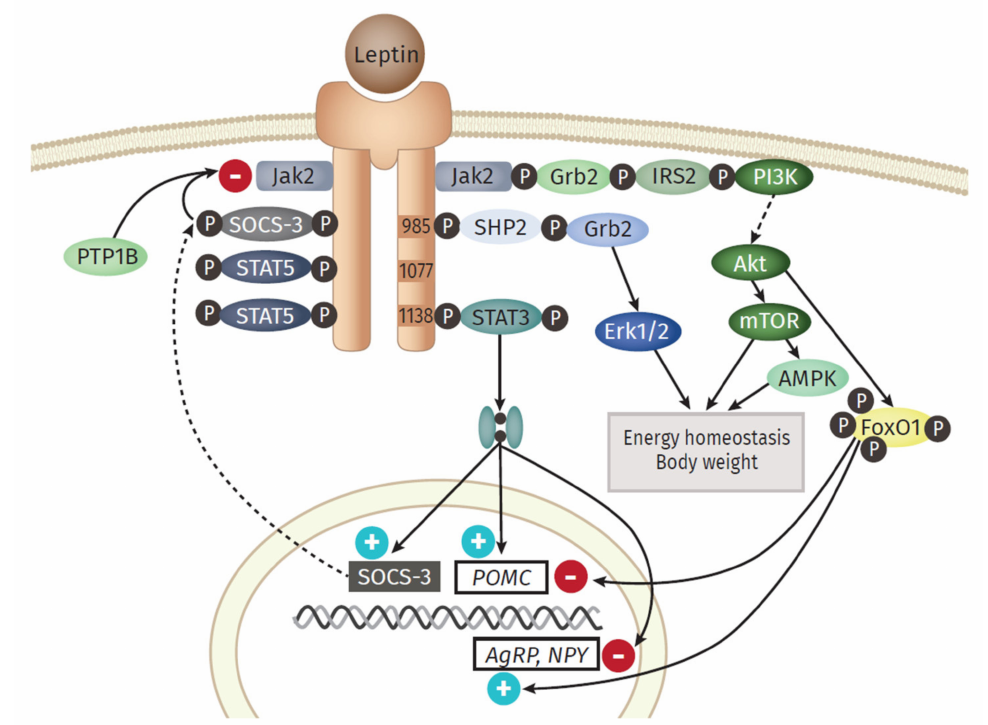
Figure 2. Overview of the leptin signaling pathway. The long isoform of the leptin receptor (ObRb) possesses the whole intracellular domain, with the conserved tyrosine residues (Y985, Y1077, Y118). The central function of leptin in the hypothalamus is regulated via the activation of anorexigenic neurons and orexigenic Neuropeptide Y (NPY)/Agouti-related Protein (AgRP) neurons. The most prominent downstream signaling component of the leptin receptor is the Janus kinase (JAK)/signal transducer and activator of transcription (STAT) pathway. After binding of leptin, subsequent dimerization of the receptor and the following activation of JAK2 occurs, followed by the recruitment of the Src homology 2 (SH2) domain of STAT3 to the conserved phosphorylated tyrosine Y705 residue. Hereinafter, STAT3 itself is phosphorylated by the JAKs at position Y705, dimerizes, and translocates into the nucleus. At this point, it serves as a regulator of the expression of different STAT3 responsive genes. One prominent downstream gene is the suppressor of cytokine signaling 3 (SOCS3), which itself acts as a potent negative regulator of the leptin signaling, by binding of Y985 domain and following inhibition of JAK2. Protein tyrosine phosphatase 1 B (PTP1B), produced in the endoplasmic reticulum (ER), is further able to inhibit leptin signaling by dephosphorylating JAK2. Besides STAT3, STAT5 is also known to be activated and phosphorylated in vivo. Another downstream signaling branch of leptin is the Mitogen-activated protein kinase (MAPK) pathway. Here, the SH2 domain of the phosphatase SH2- containing protein tyrosine phosphatase 2 (SHP2) binds to pY985, becomes phosphorylated by JAKs, which finally activates MAPK extracellular signal-related kinase (ERK1/2) via recruitment of growth factor receptor-bound protein 2 (Grb2). The phosphatidylinositol 3 kinase (PI3K) signaling pathway is activated by leptin. IRS 2 (insulin receptor substrate 2) binds to ObRb through the SH2B1 domain, able to interact and upregulate JAK2. Those IRS proteins are then capable of binding and activating PI3K yielding the subsequent accumulation of phosphatidylinositol 3,4,5-triphosphate (PIP 3 ) and activation of 3-phosphoinositide- dependent protein kinase (PDK1) and Akt. The latter inhibits forkhead box O1 (Foxo1), the mediator of the previously mentioned function of leptin in the hypothalamus. Another component downstream of Akt is the Ser/Thr kinase mTOR (mammalian target of rapamycin), another sensor of the availability of nutrients and stimulator of cell growth, protein biosynthesis, and proliferation. The AMPK (adenosine monophosphate-activated protein kinase) pathway is stimulated by leptin as well, but the outcome differs between the tissues. While activated in hepatocytes and muscle, AMPK is inhibited in the hypothalamus, resulting in inhibition of food